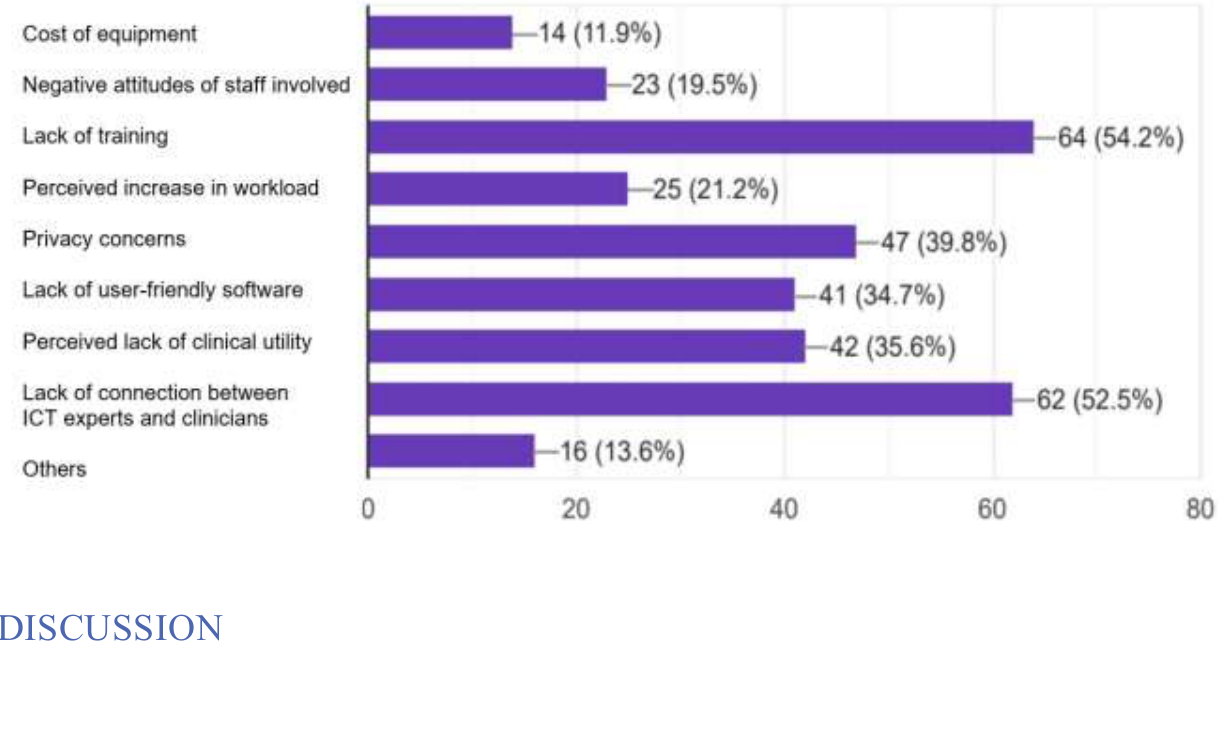
Barriers to Telerehabilitation Usage Identified by